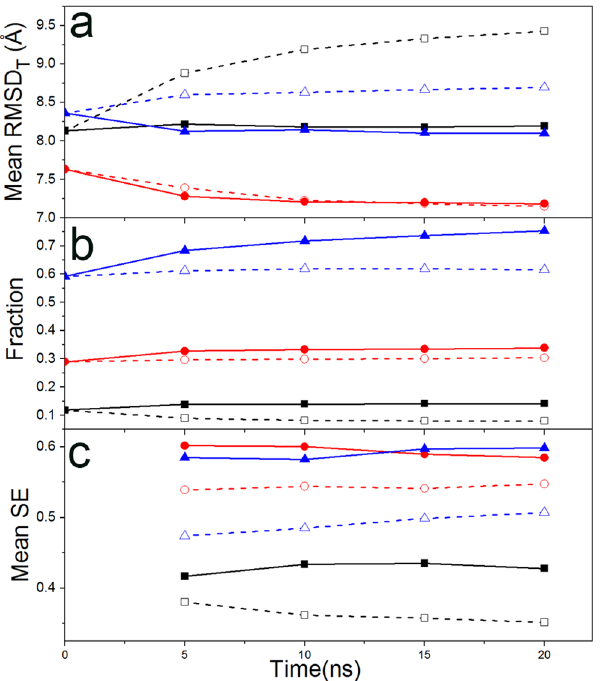
Fig 5. Comparison of RMSD T , fractions of secondary structures and sampling efficiency in the backward simulations. Three parameters are calculated from 370K backward simulations against simulation time, for RMSD T (a), fractions of accordant secondary structures to their targets (b) and the actual mean SE (c). The solid symbols are from the hybrid MD-MC simulations, and the empty symbols are those from the parallel MD simulations. The square, circle and triangle present the target with sheet, helix and coil secondary structures,